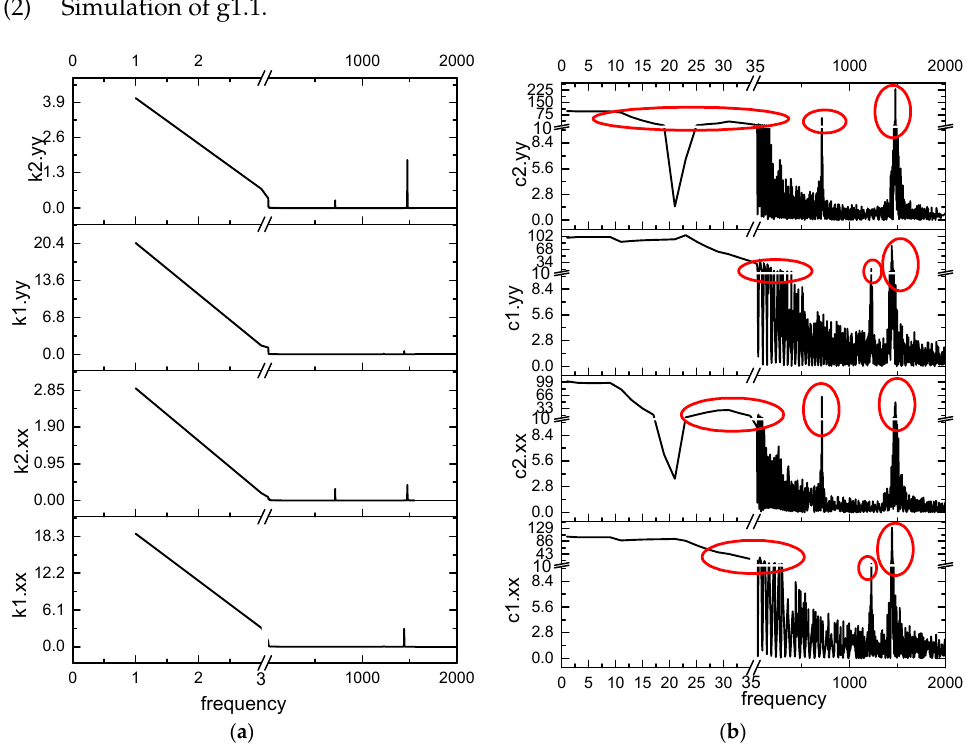
Figure A5. Identified bearing coefficients changing with frequency of g1.1 based on algorithm I considering adjustment point and sensor resolution 1 am: ( a ) obtained main stiffness coefficients in x and y directions; ( b ) obtained main damping coefficients in x and y directions.